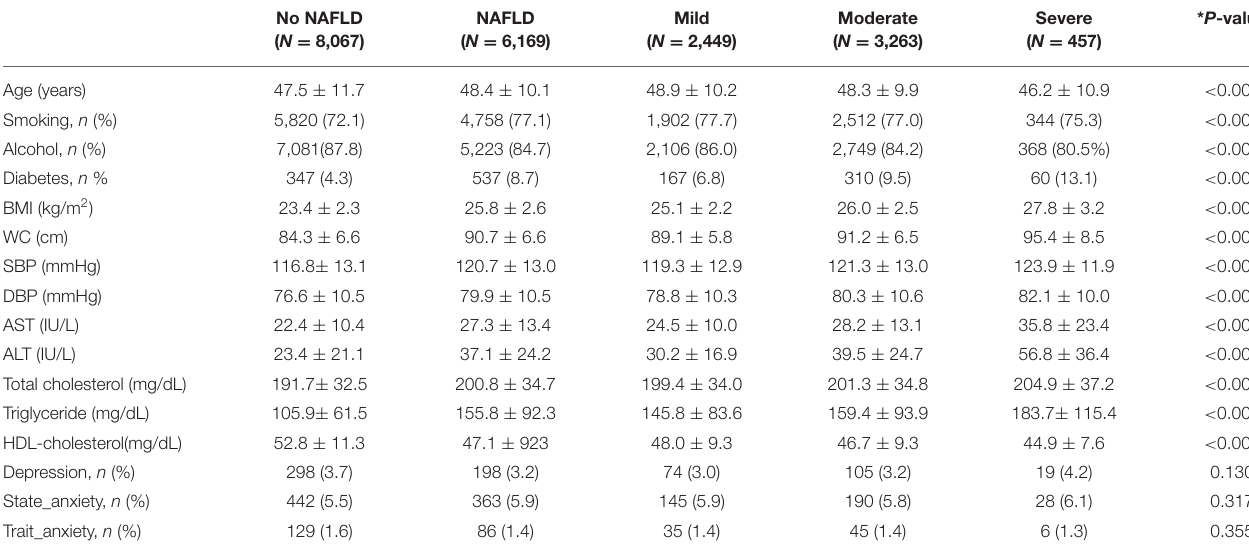
TABLE 1 | Comparison of baseline characteristics according to nonalcoholic fatty liver disease in males.